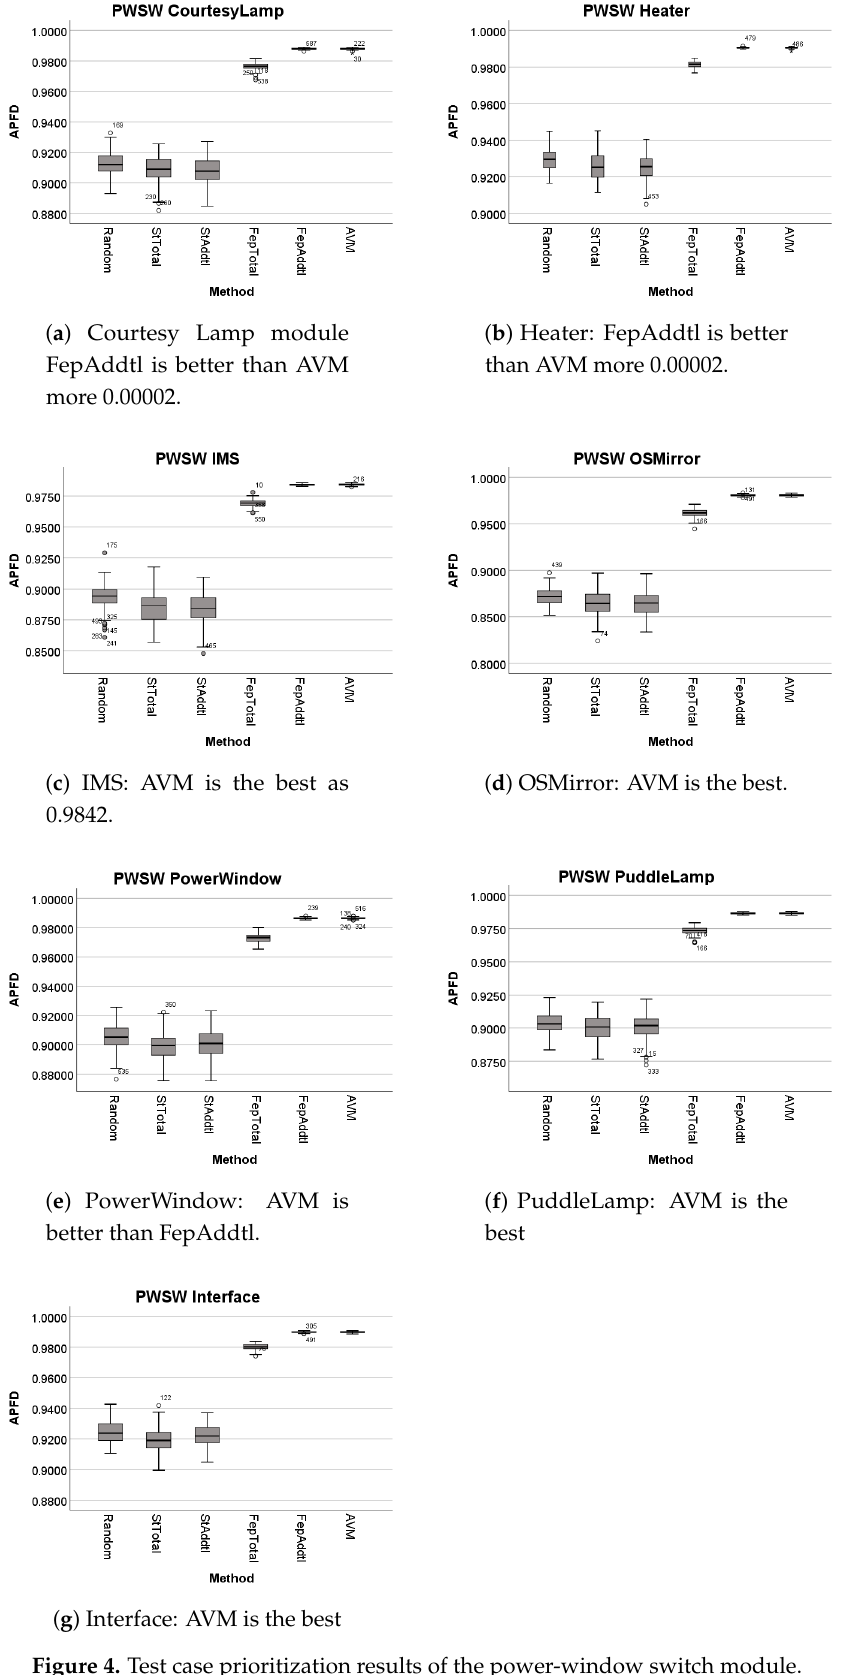
Figure 4. Test case prioritization results of the power-window switch